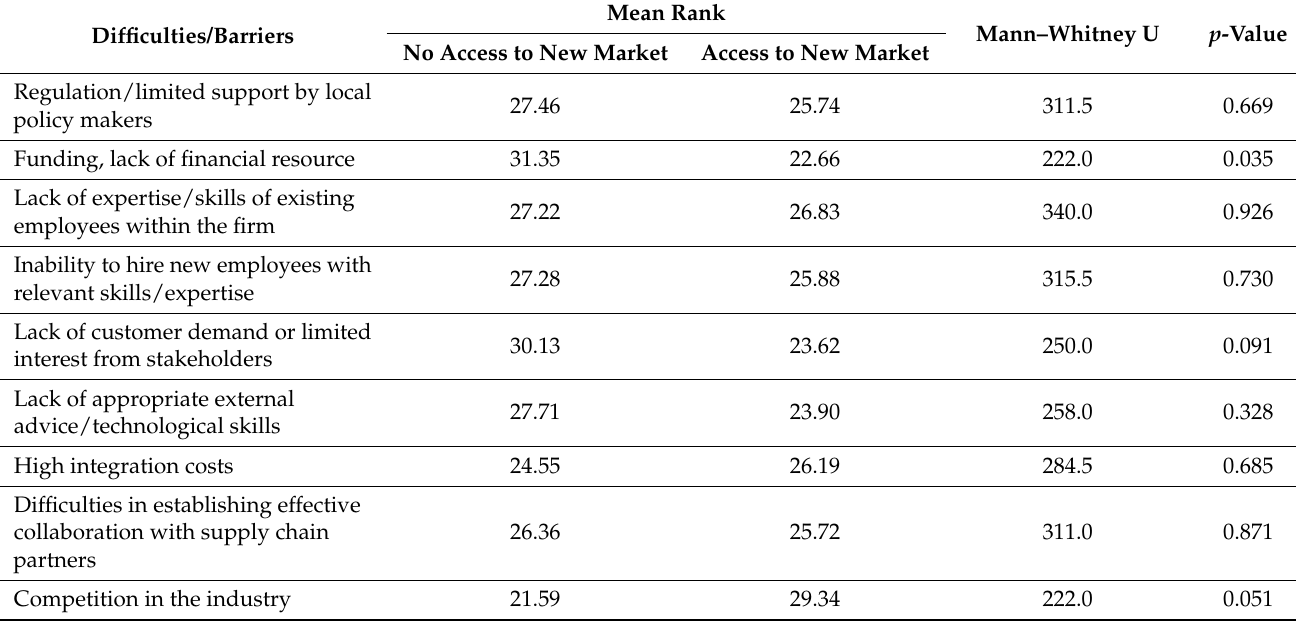
Table 5. Difficulties/barriers of rural SMEs during the adoption/integration of new technology—access to new market.